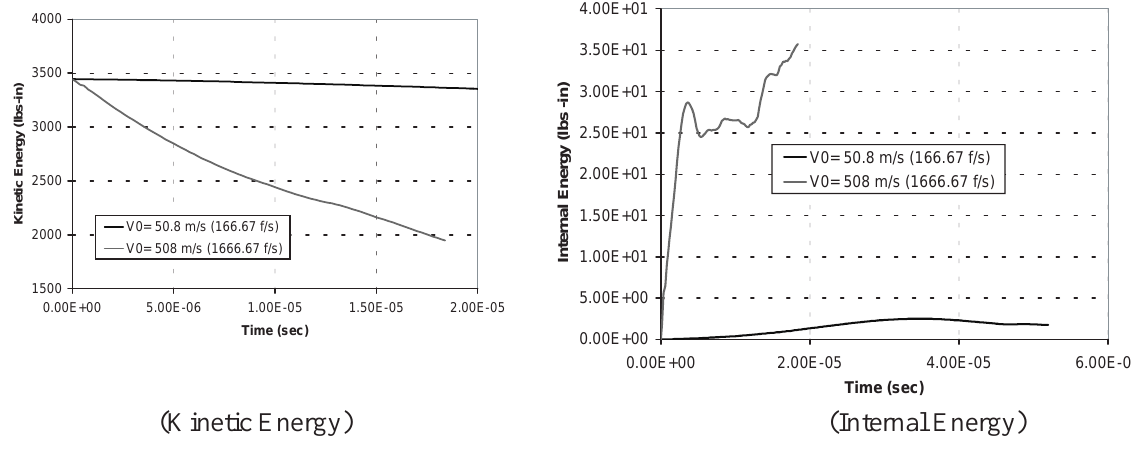
Fig. 15. Comparison of time histories of kinetic/internal energies for low and high velocity